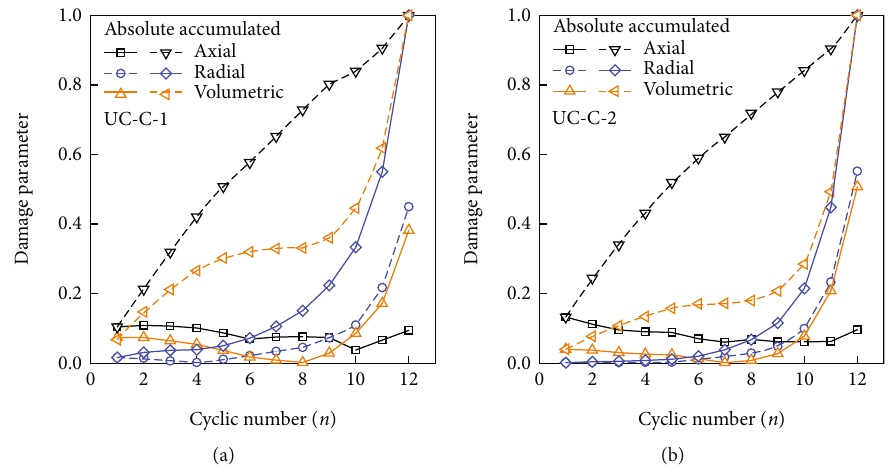
Figure 9: Damage parameters of sandstone with di ff erent cyclic numbers: (a) UC-C-1; (b)